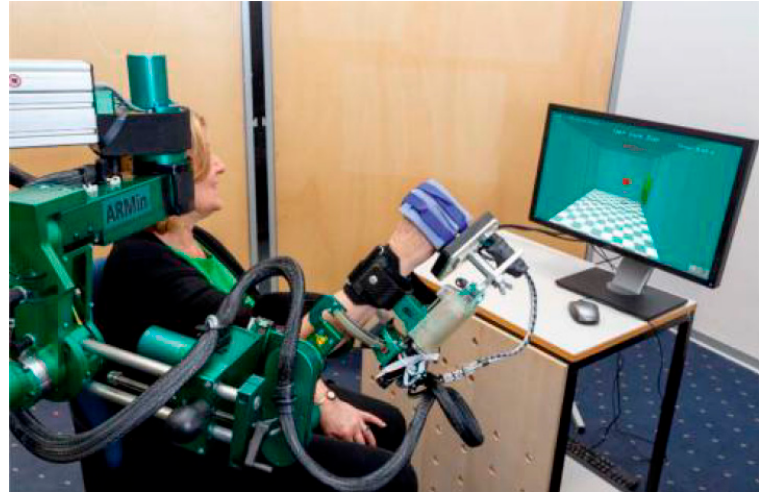
Figure 5. ARMin rehabilitation robot. Source: [44].